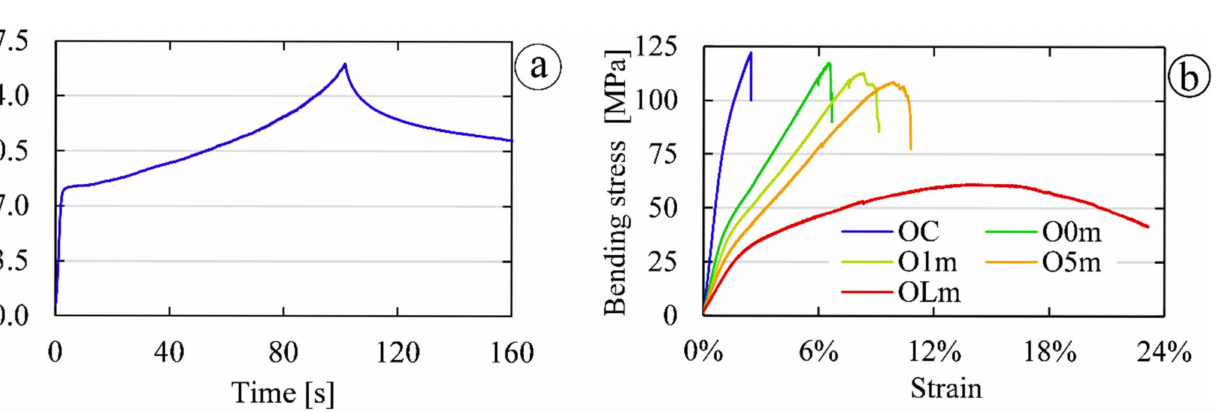
Figure 12. ( a ) Typical stress–time graph of compression followed by fixation for 1 min, reproduced from [110], licensed under CC BY 3.0; ( b ) Typical stress–strain graphs of oak samples for 4-point bend- ing test data with different fixation times. Reproduced from [9], with permission from Pulp and